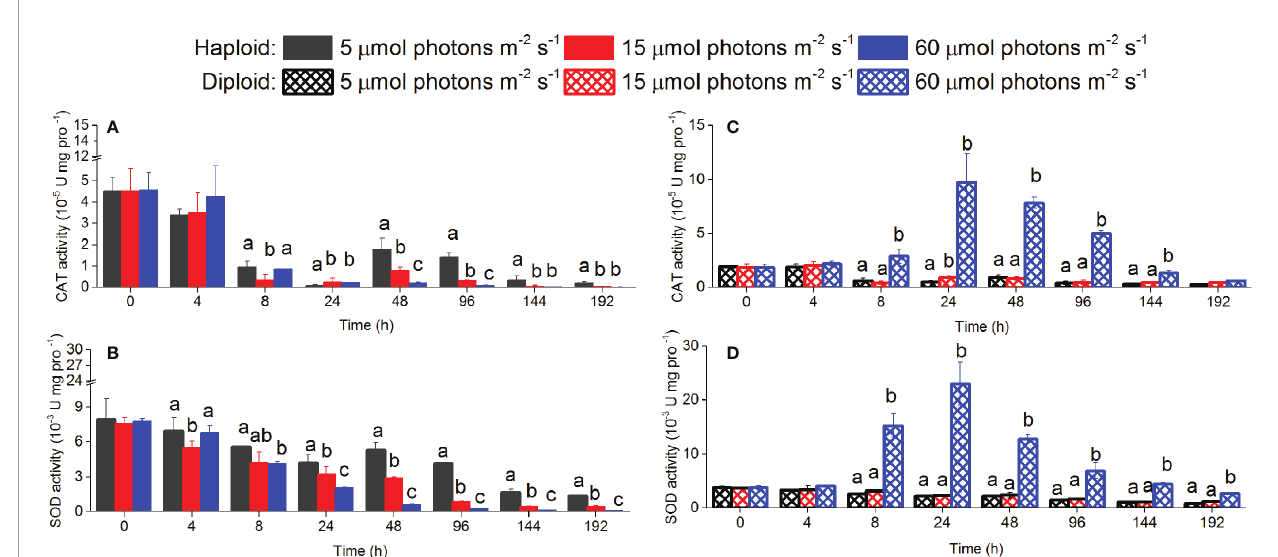
FIGURE 6 | CAT and SOD activities in haploid and diploid solitary cells of P. globosa at 0 h, 4 h, 8 h, 24 h, 48 h, 96 h, 144 h and 192 h under different irradiance treatments. Different lowercase letters indicate signi fi cant differences among the three light intensities at the same time. (A, B) for haploid cells; (C, D) for diploid solitary